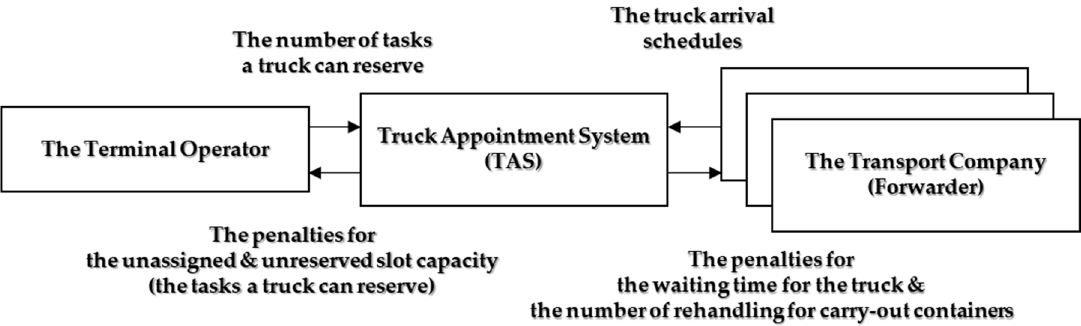
Figure 2. A framework of the new Truck Appointment System (TAS).